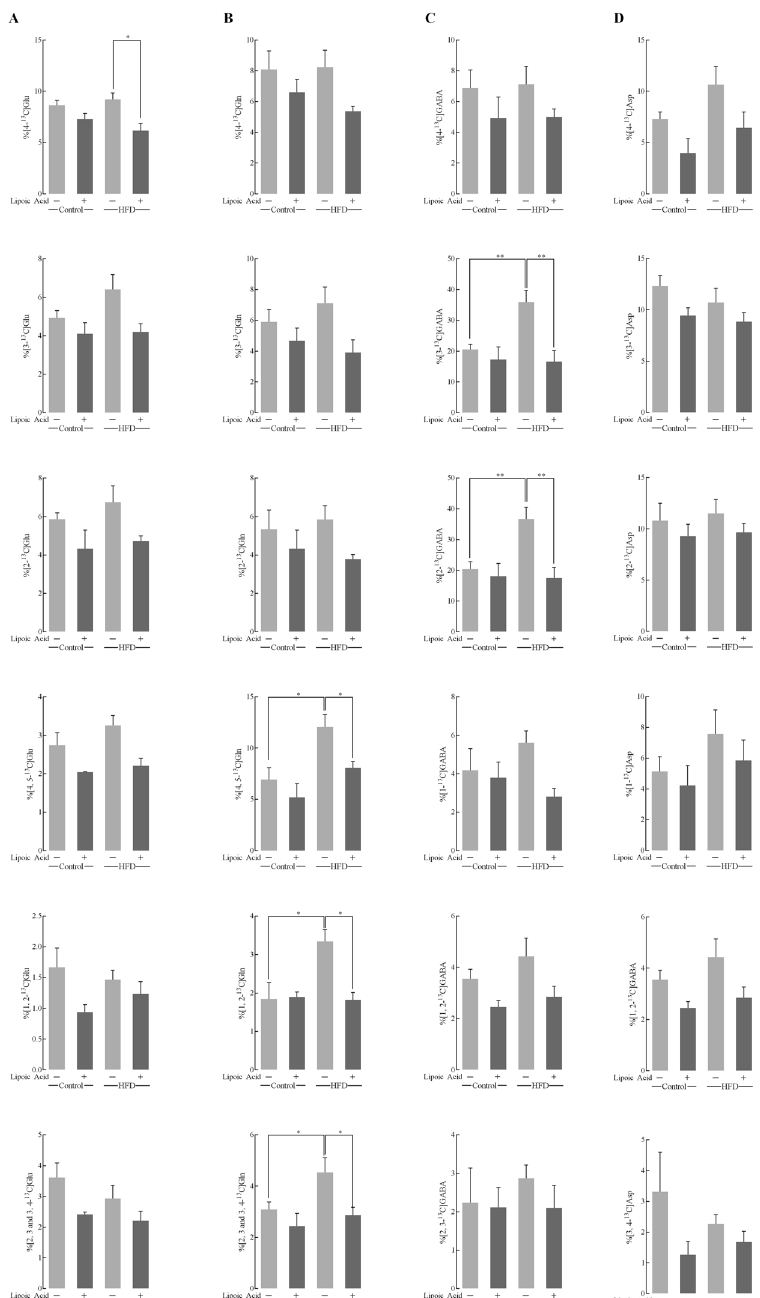
Figure 4. 13 C enrichment percentage of the major metabolites isotopomers after [1- 13 C]-glucose and [1,2- 13 C]- acetate infusion. These 18- bar graph show the different 13 C labeled glutamate (column A ), glutamine (column B), GABA (column C ), and Aspartate (column D ) isotopomers after infusion of [1- 13 C]-glucose + [1,2- 13 C]- acetate for 60 min. The enrichment of each metabolite isotopomers was calculated as described in Materials and methods section. Data presented as mean ± SD, n ≥ 4, * p < 0.05, ** p <